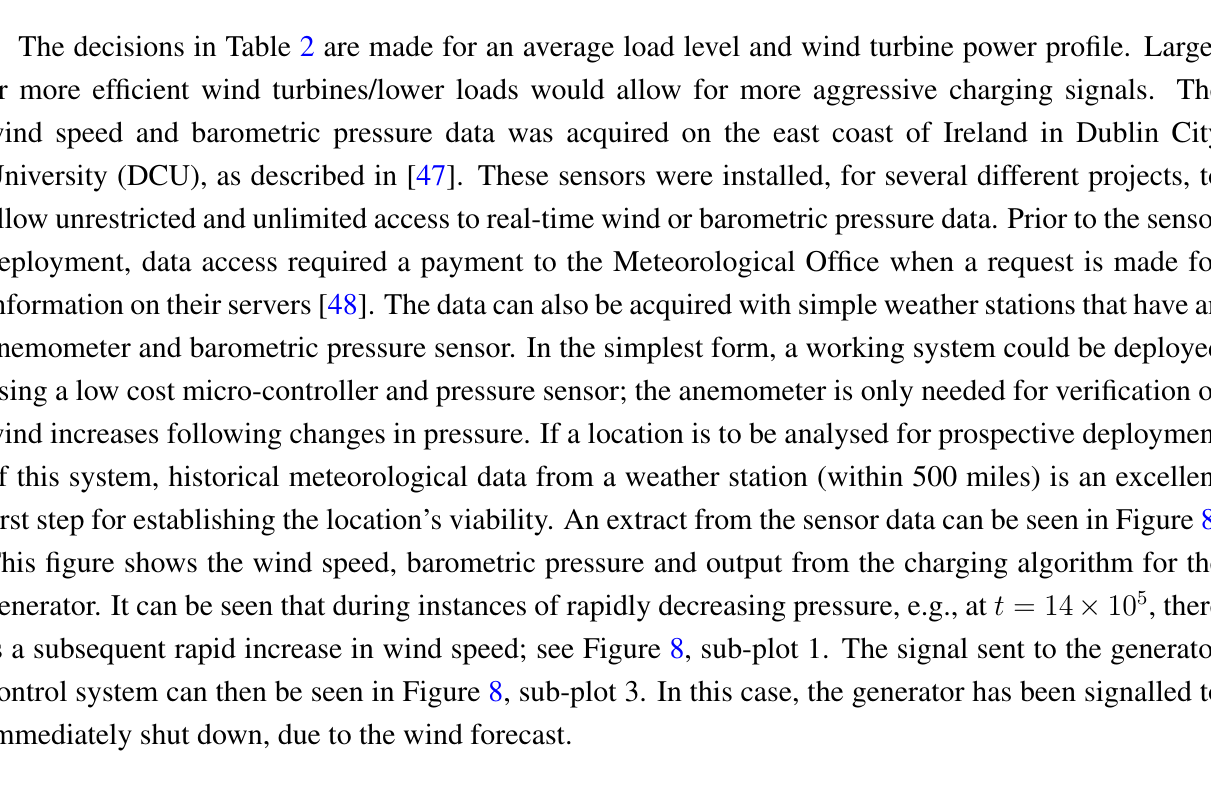
Figure 8. The effect of barometric pressure on the charging